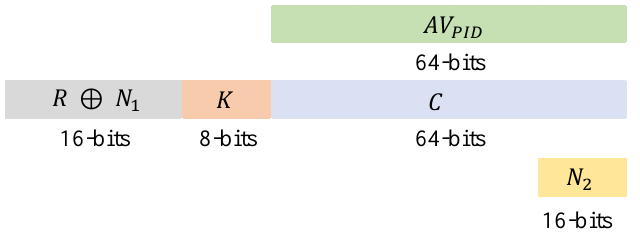
Figure 15. Total message flow of the proposed framework. Table 7. Communication overhead.